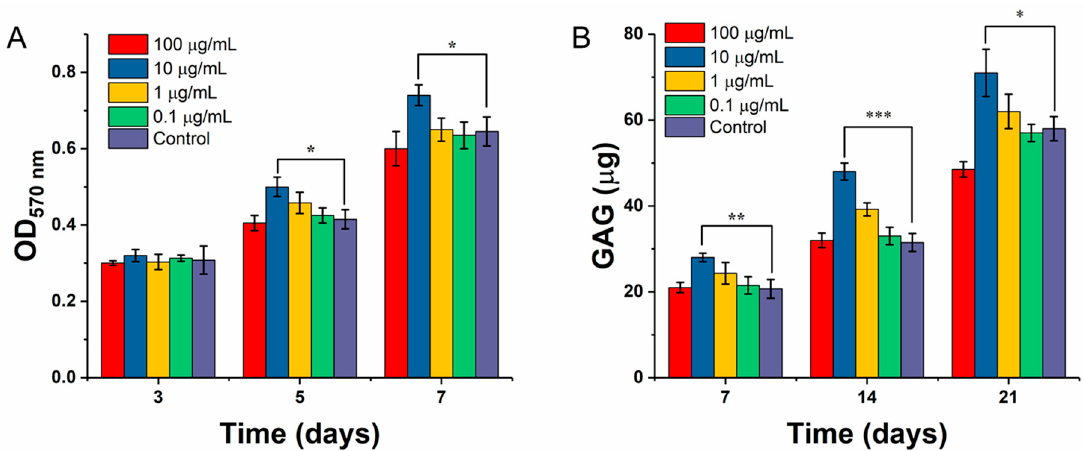
Figure 12. Chondrocyte growth and proliferation over the designed SA-Gel scaffolds in the presence of ICA. ( A ) Cell proliferation by MTT assay; ( B ) GAG secretion by DMMB assay on the SA-Gel scaffolds in the presence of ICA. (* represents p < 0.05, ** represents p < 0.01, and *** represents p < 0.005).